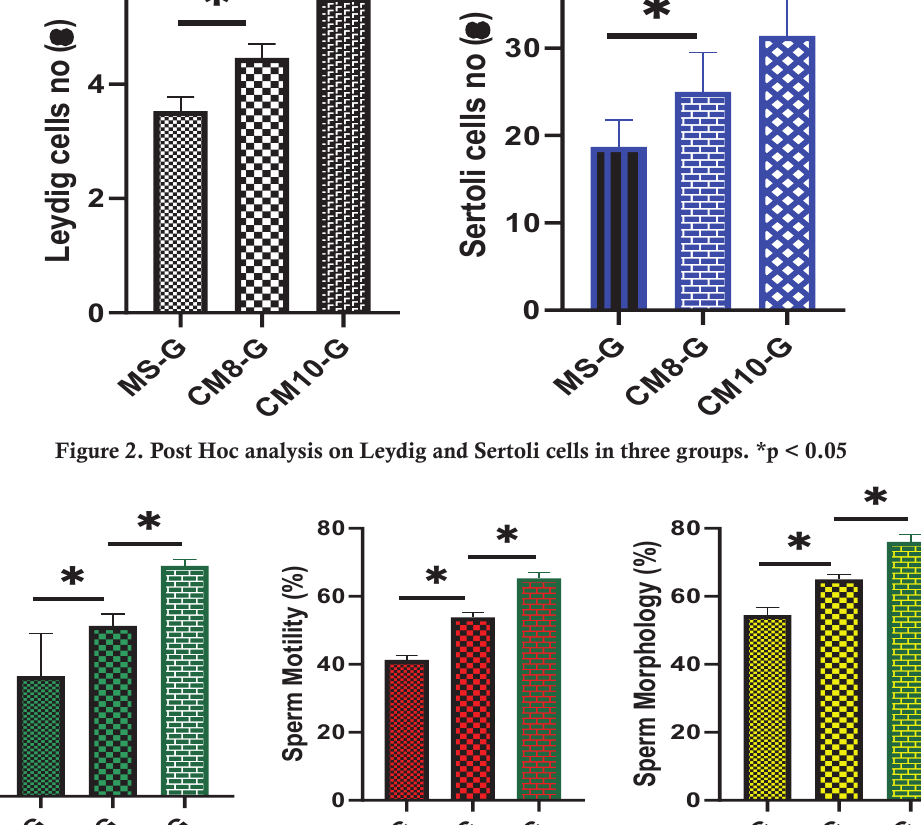
Figure 3. Post Hoc analysis on sperm quality in each group. Sperm density, Sperm